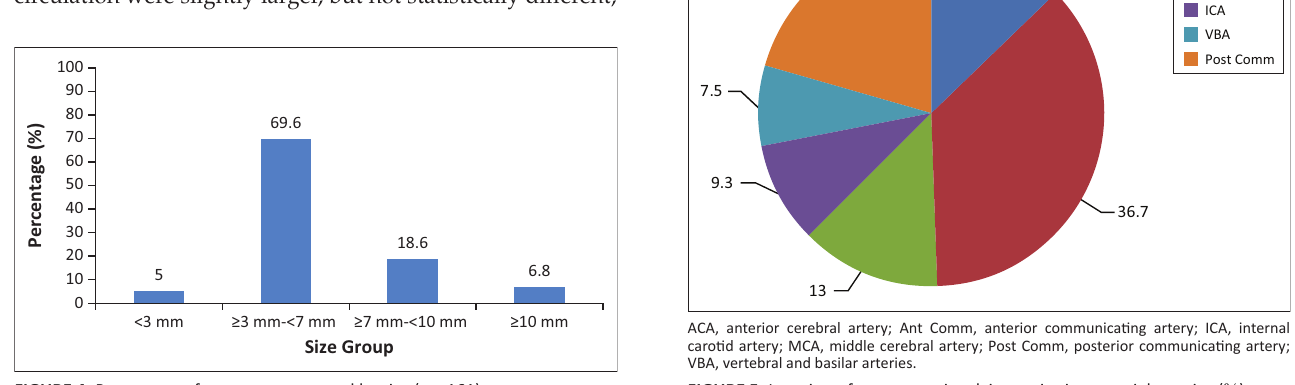
FIGURE 4: Percentage of aneurysms grouped by size ( n = 161). FIGURE 5: Location of aneurysms involving major intracranial arteries ( % ). TABLE 1: Location of aneurysms by main vascular circulation and main vessels. Main vascular locations grouped by